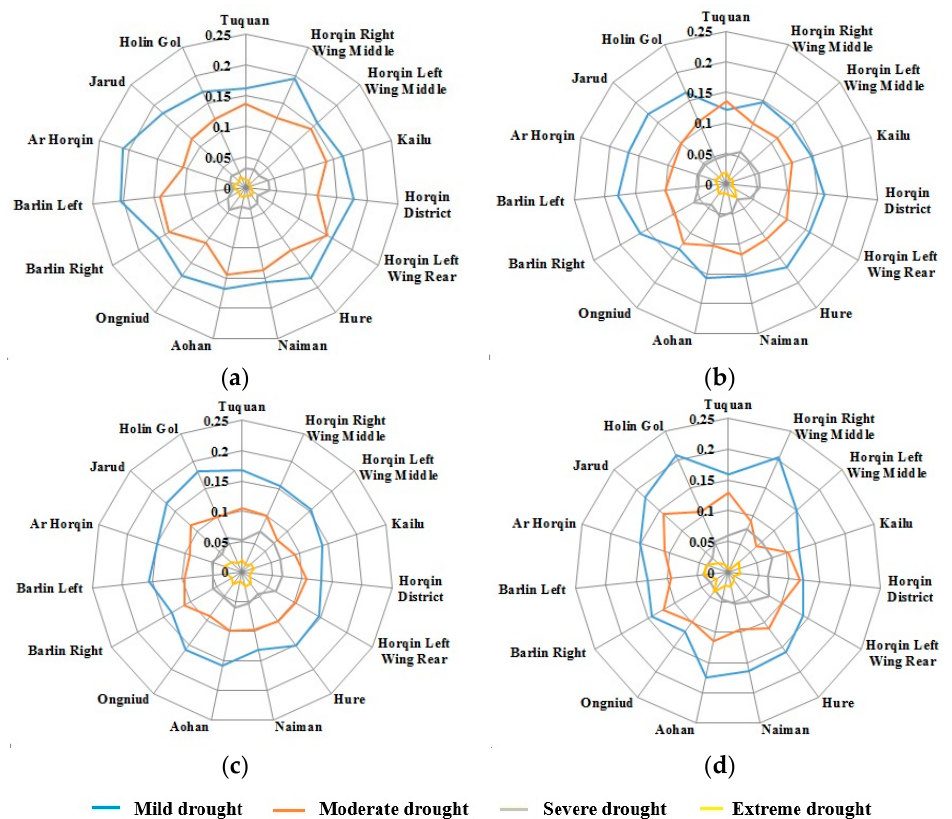
Figure 4. Drought months of different grades of drought severity in Horqin Sandy Land based on SPEI ‐ 1 ( a ); SPEI ‐ 3 ( b ); SPEI ‐ 6 ( c ); and SPEI ‐ 12 ( d ).